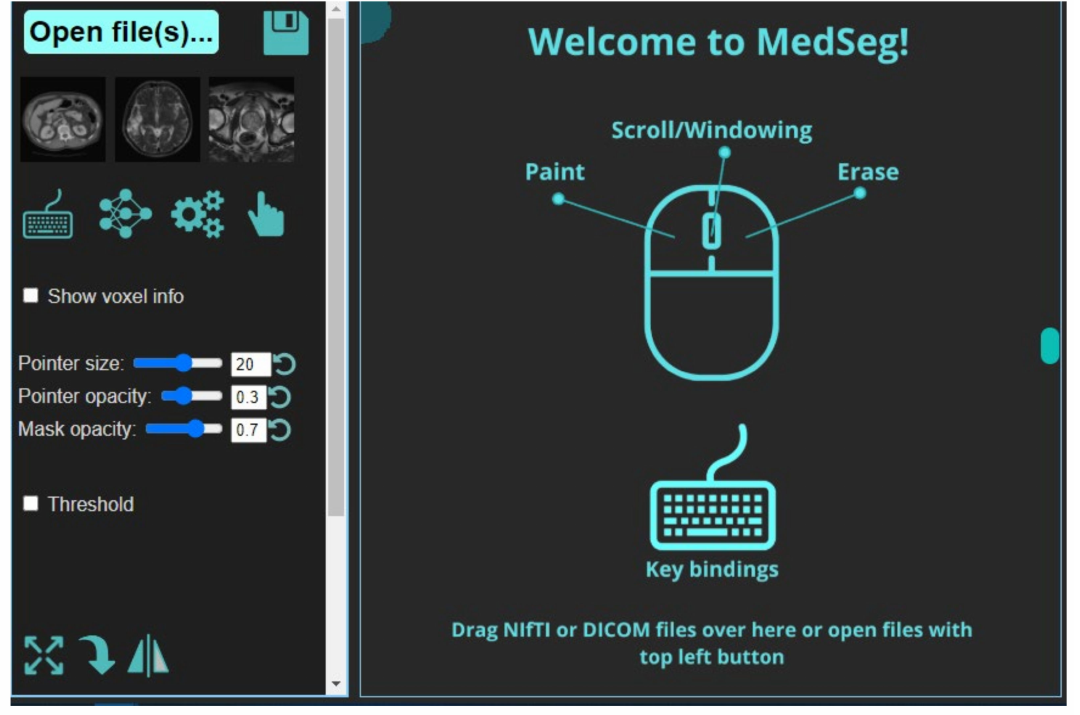
Figure 6. Opening page of the MedSeg tool.